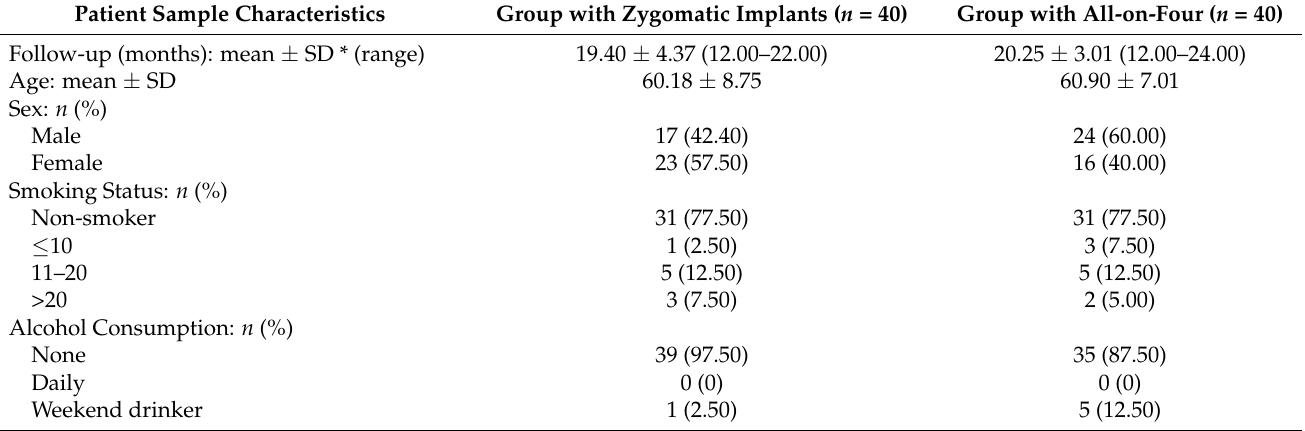
Table 1. Study population